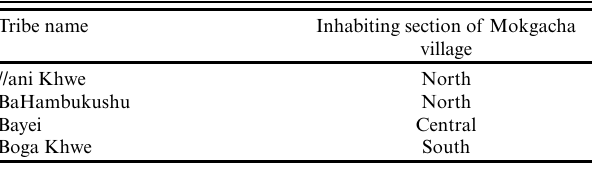
Table 1 . The different tribes inhabiting the study site according to the section of Mokgacha village where they